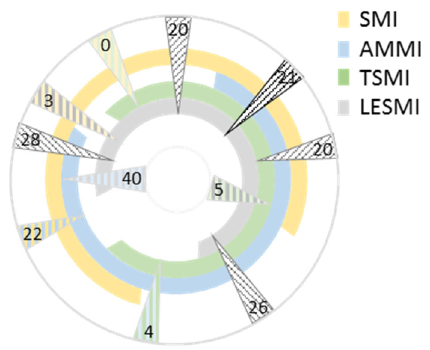
Figure 3. Comparison of the numbers of sarcopenic individuals identified by skeletal muscle mass based indices. Each partial circle depicts an index. The arrows show the compared indices. The darker the arrow, the more indices are compared. The number in the arrows indicate the numbers of individuals identified as sarcopenic by the compared indices. SMI: skeletal muscle mass index; AMMI: appendicular skeletal muscle mass index; TSMI: total skeletal mass index; LESMI: lower extremity skeletal muscle mass index.